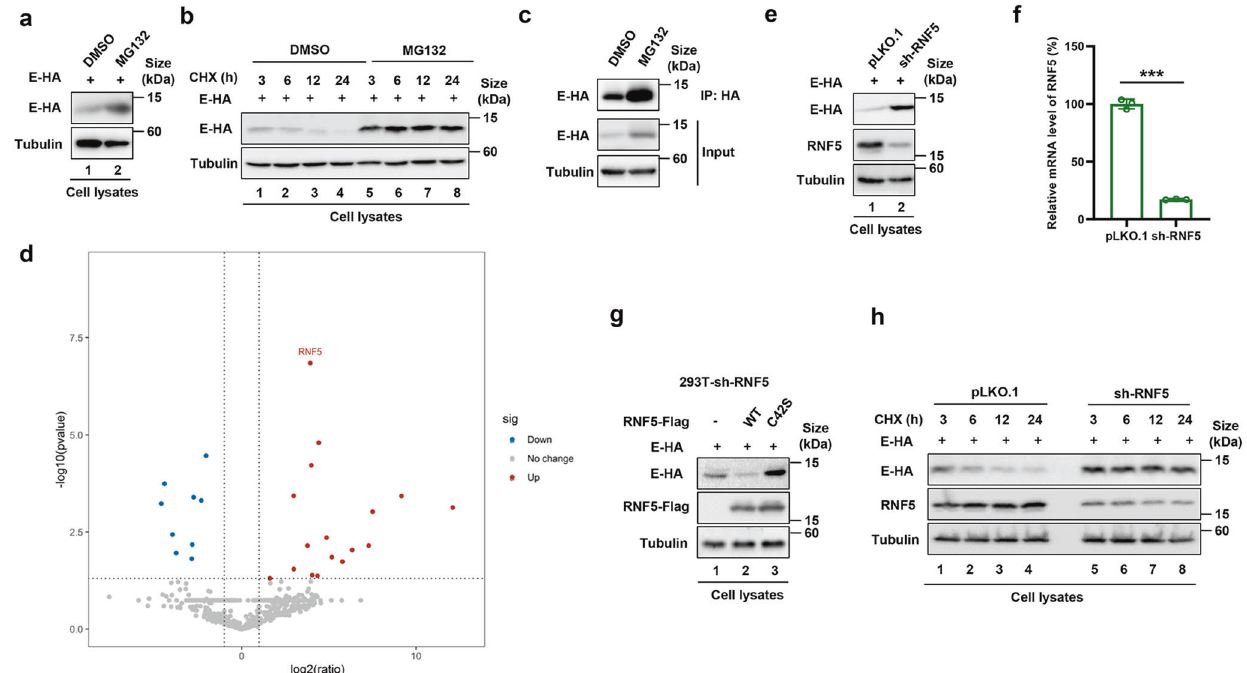
Fig. 1 Identi fi cation of the E3 ubiquitin ligase RNF5 as a factor involved in degradation of the E protein of SARS-CoV-2. a The proteasomal inhibitor MG132 increased the stability of the E protein. b MG132 enhanced the half-life of the E protein in cells treated with cycloheximide (CHX). HEK293T cells transfected to express E-HA for 24 h were treated 10 µM MG132 for 10 h. For CHX treatment, cells were harvested at the indicated time points after adding the inhibitor at 50 μ g/mL. Cleared lysates resolved by SDS-PAGE were probed by immunoblotting (IB). c Immunoprecipitation (IP) of the E protein after MG132 treatment. HEK293T cells transfected to express E-HA were treated with MG132 for 10 h prior to harvest. Lysates were subjected to HA IP and eluents were analyzed by mass spectrometry. d Volcano plot of binding proteins with RNF5 in eluents. Black circles represent proteins that were not signi fi cantly changed. Red circles represent proteins that potentially interact with the E protein, blue circles represent non-binding proteins. e Knockdown of RNF5 increased E stability. f mRNA level of silenced RNF5 by RT-qPCR. g The E3 ubiquitin ligase activity of RNF5 is required for E degradation. RNF5-silenced HEK293T cells transfected with RNF5- Flag wild-type (WT) or its C42S mutant for 36 h were harvested and analyzed by IB. h Knockdown of RNF5 prolonged the half-life of the E protein. HEK293T cells receiving RNF5 silencing or the negative control pLKO.1 were transfected with the E-HA plasmid, and then treated with 50 μ g/ml of CHX prior to being harvested at the indicated time